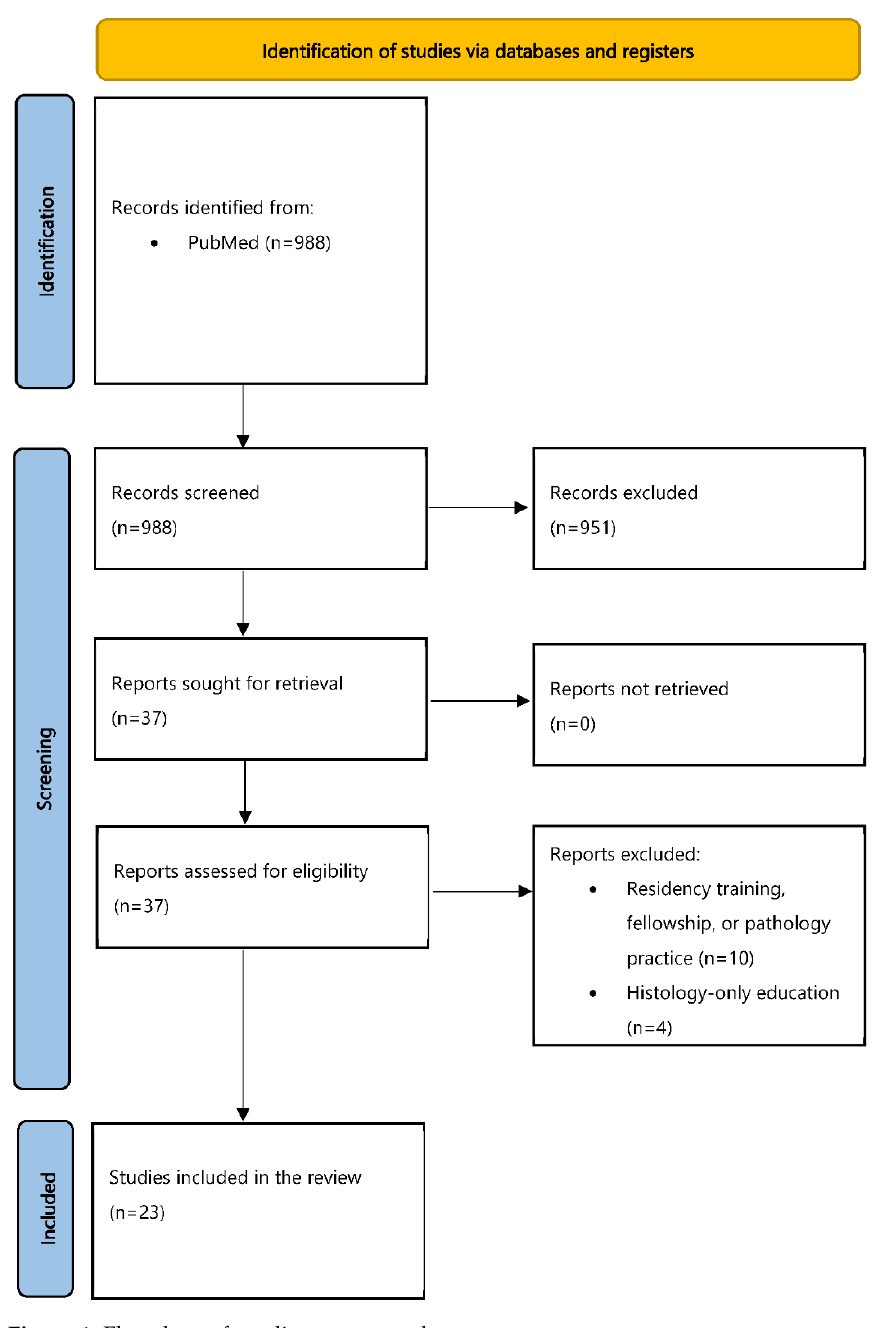
Figure 1 . Flowchart of our literature search Figure 1. Flowchart of our literature